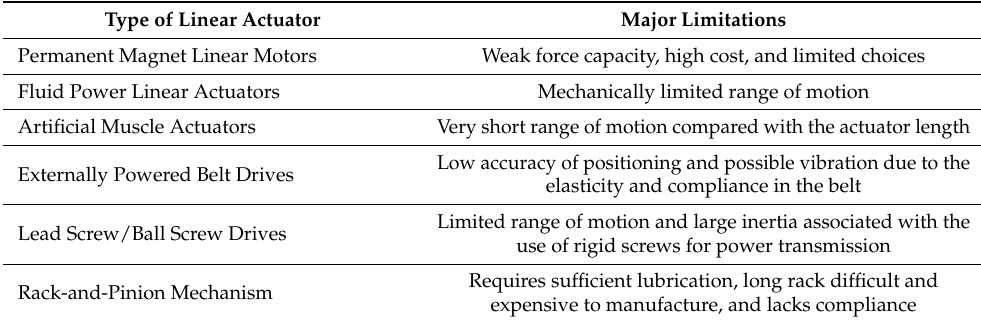
Table 1. Limitations of the existing linear actuators.